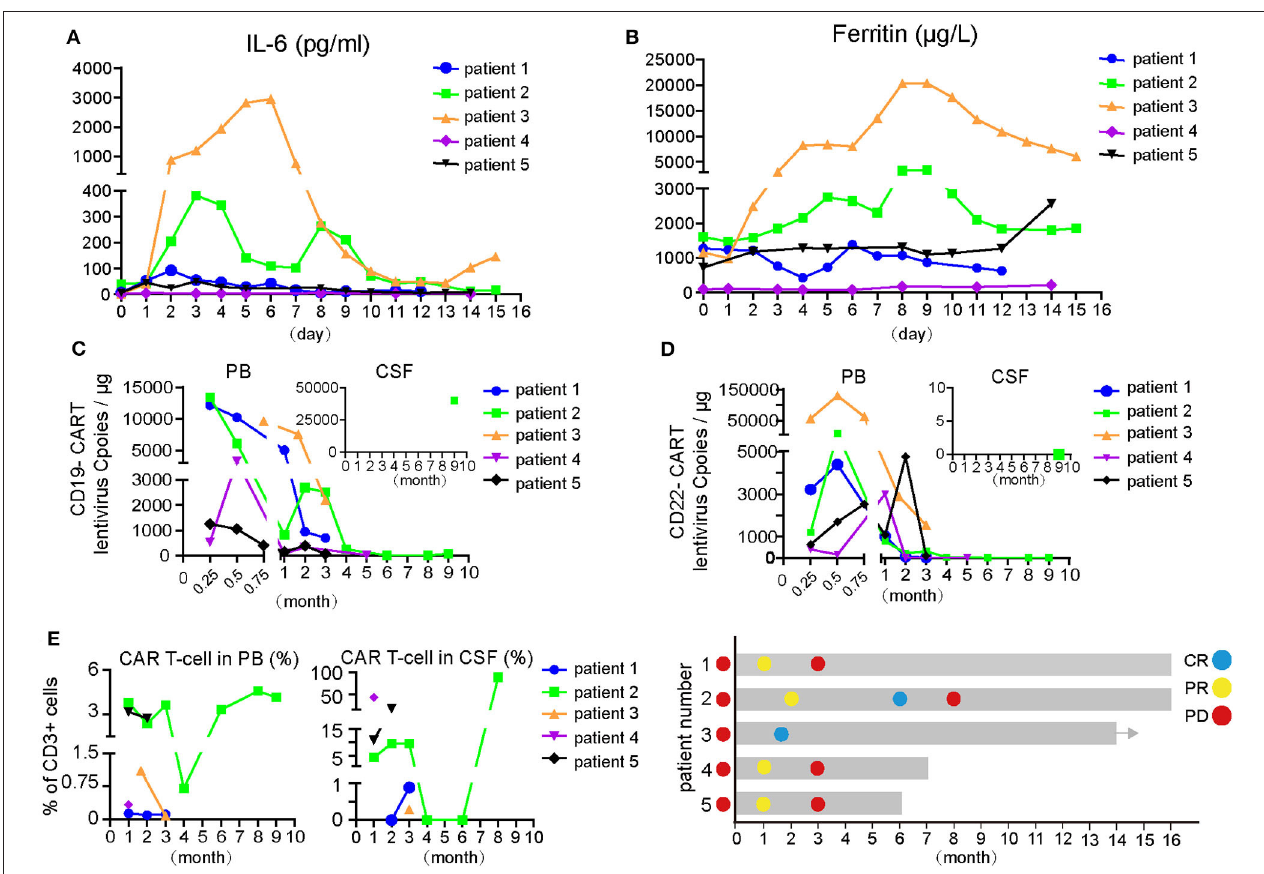
FIGURE 1 | Changes of indicators during CAR-T cell therapy and therapeutic effect of CAR T treatment. (A,B) IL-6 and ferritin level of the five patients during CAR-T cell therapy. The day of first CAR T-cells infusion was as day 0. (C) Dynamic changes of lentivirus copies of CD19- or CD22-CAR-T cells in PB and partial in CSF after CAR-T cell therapy. Expansion of anti-CD19 or CD22 CAR-T cells in vivo were quantified by ddPCR at multiple time points after infusion. (D) Changes of total CART percent of the 5 patients in PB and CSF, respectively, after CAR-T cell therapy. The proportion of CAR-T cells in CD3 positive T cells was detected by flow cytometry. (E) Therapeutic effect and disease status of the five patients. Different colored dot represents the disease status, on the left of the Y -axis is the disease status before CAR-T cell therapy and right is on behalf of dynamic disease status after CAR-T cell therapy. Arrows indicate the ongoing status until now. CSF, cerebrospinal fluid; CR, complete remission; PR, partial remission; PD, progressive